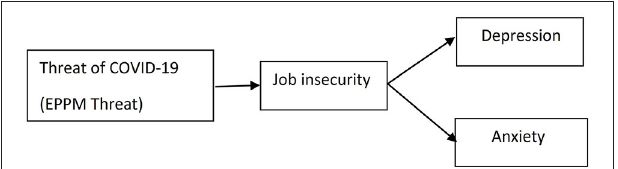
FIGURE 1 | Research model of the